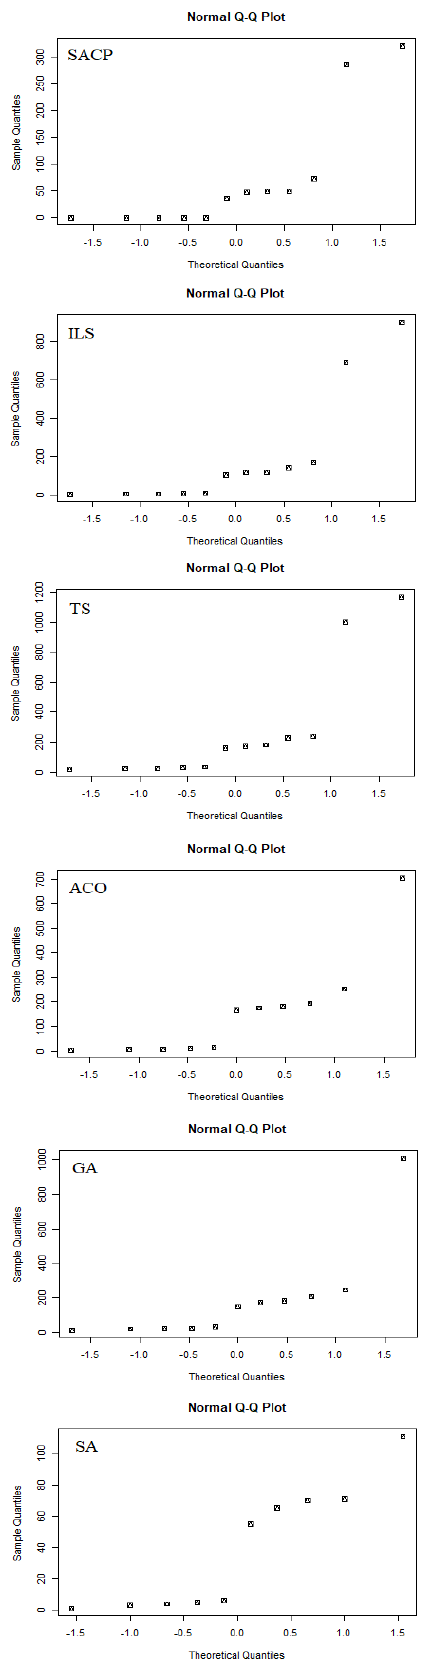
Figure 10. Normality graphs for SACP, ACO, GA, ILS, TS and SA algorithms.